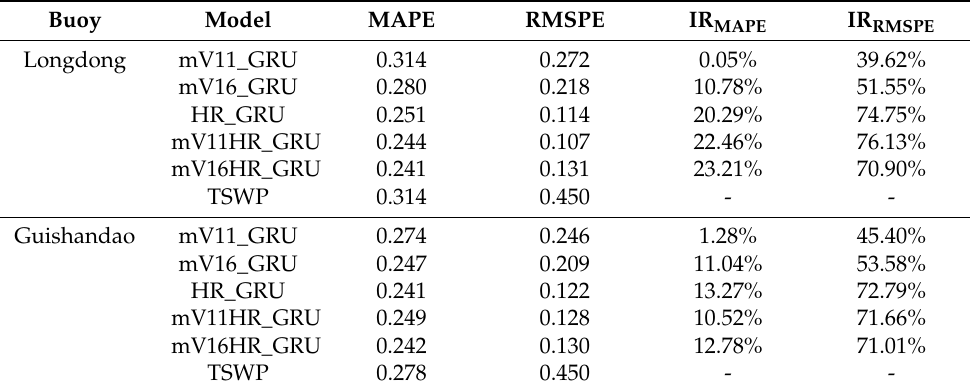
Table 7. Average of the MAPE and RMSPE and their IR at lead time of 1 to 6 h at Longdong and